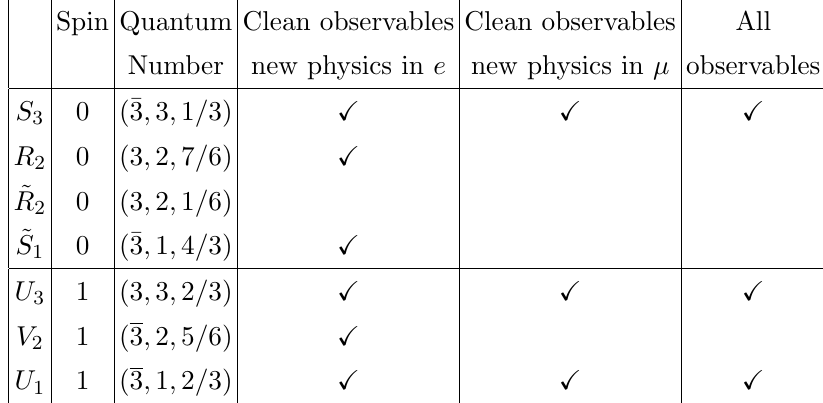
s‘ + ‘ (cid:0) anomalies. !